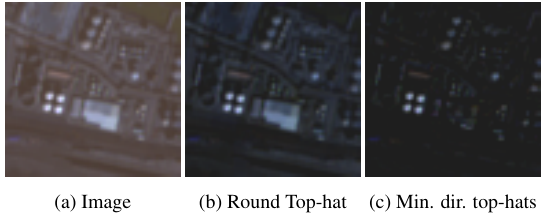
Figure 4. Top-hat with a round structuring element vs the minimum of directional top-hats. Diameter is 11px for both cases. We can see that the round top-hat retains both the buildings and the tanks, whereas the minimum of directional top-hats only retains